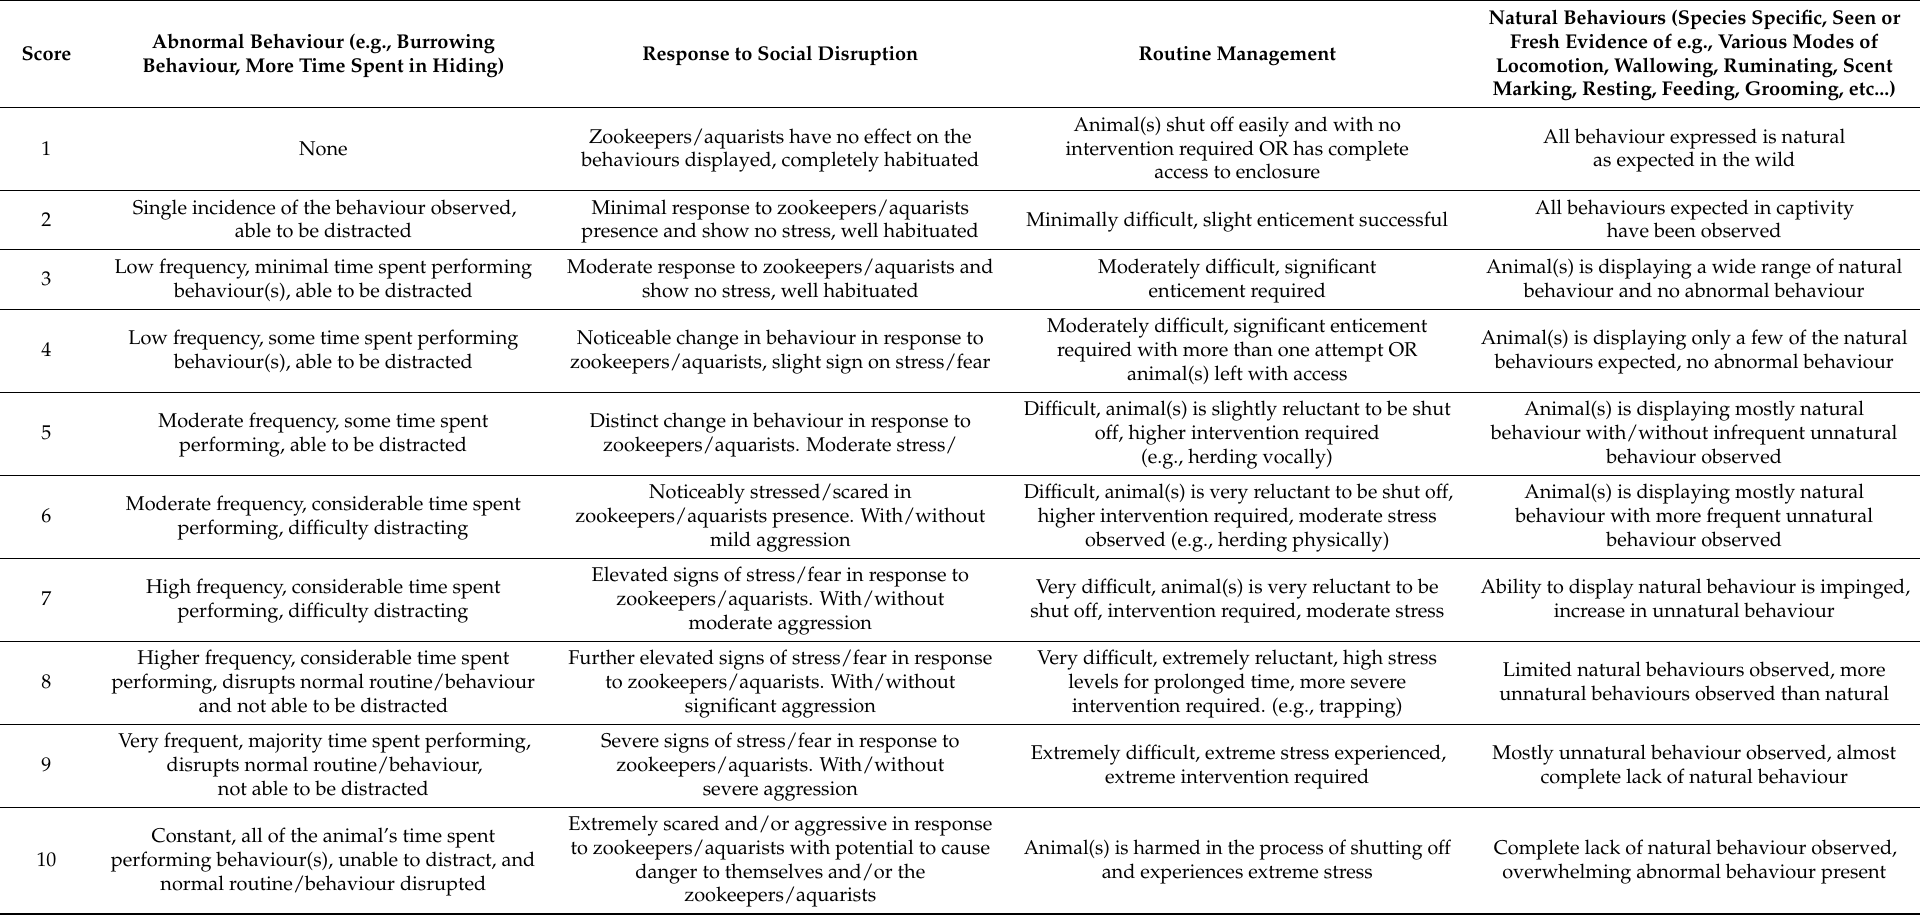
Table 2. Psychological parameter scoring for the AWAG